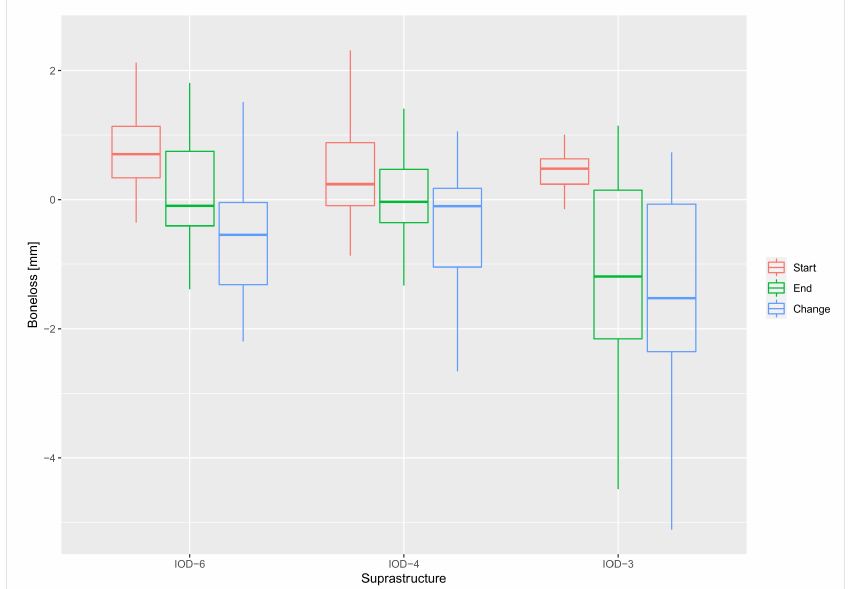
Figure 3. Boxplot of the median bone level in mm at baseline (start) and after 3–5 years (end) for all 3 treatment groups, and the overall bone loss